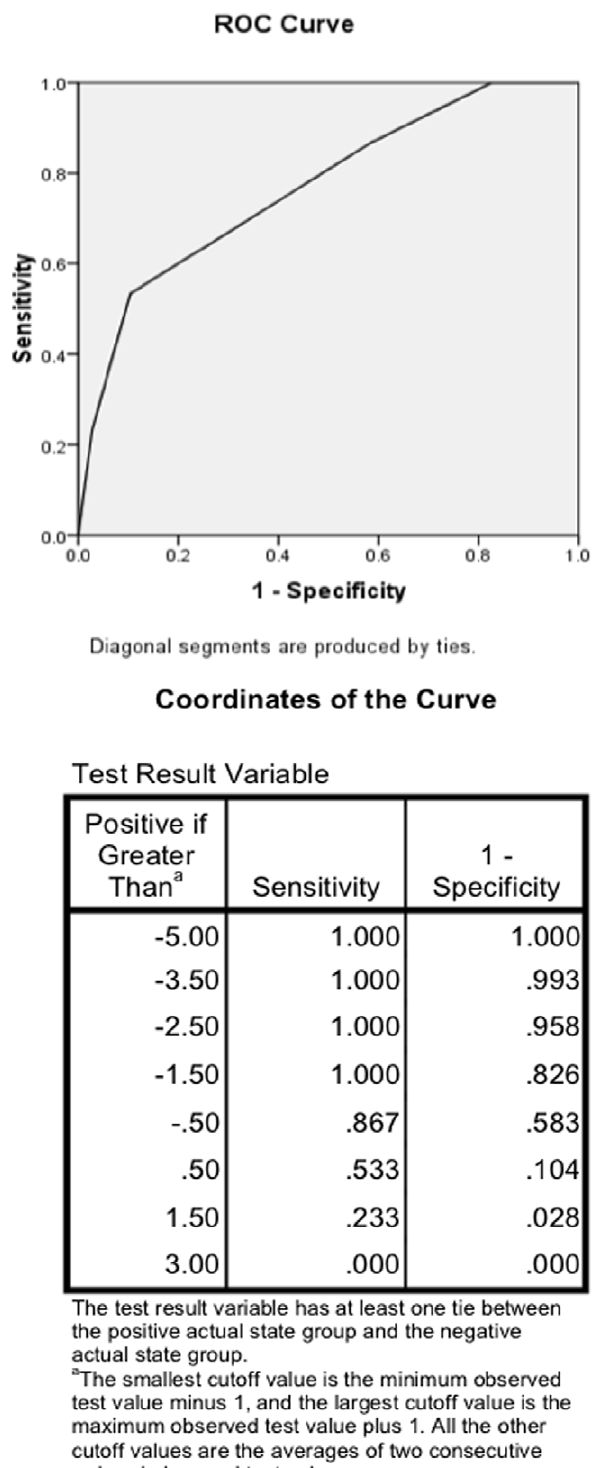
Figure 1. Receiver Operator Characteristic curve for the AIRS composite suicide risk score. This post hoc analysis shows the Receiver Operator Characteristic curve and its coordinates for the AIRS composite suicide risk score derived by subtracting scores on the individual items ‘‘Positive feelings towards self’’ and ‘‘Calm’’ from the individual item